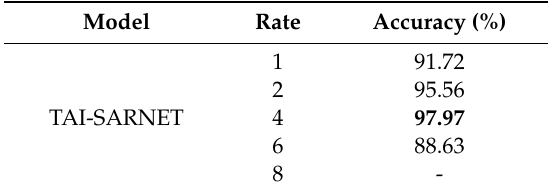
Table 3. Test result for di ff erent dilated rates.